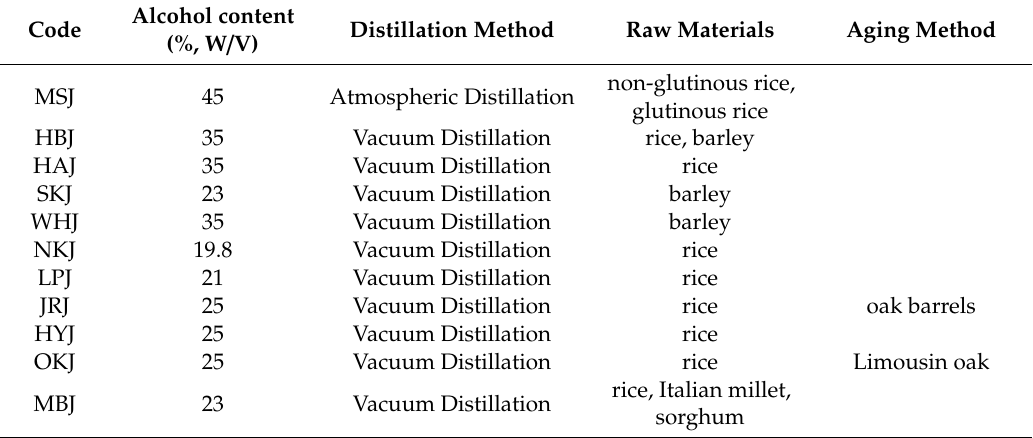
Table 1. Information about the 11 commercially distilled soju